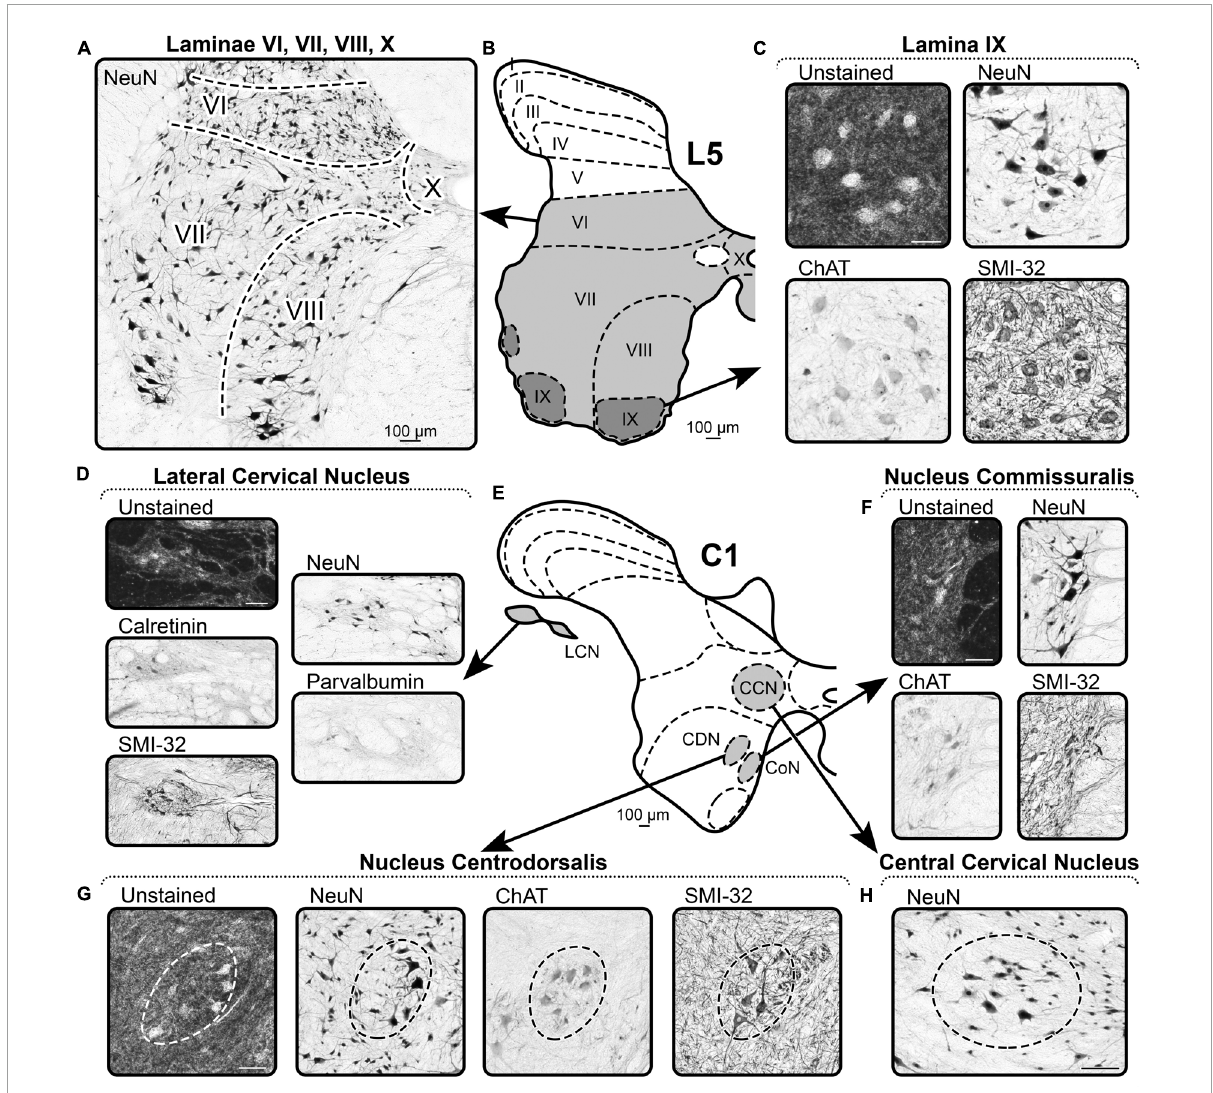
FIGURE5 A representative example of the markers of Rexed’s laminae VI–X and nuclei of spinal cord. (A–C) Spinal segment L5. (D–H) Spinal segment C1. (A) NeuN labeling in laminae VI, VII, VIII, and X. (B) Scheme of L5 segment. (C) Distribution of the markers in lamina IX. (D) Distribution of the markers in the Lateral Cervical Nucleus. (E) Scheme of C1 segment. (F) Distribution of the markers in the Nucleus Commissuralis. (G) Distribution of the markers in the Nucleus Centrodorsalis. (H) Distribution of the markers in the Central Cervical Nucleus. Scale bar is 100 µ